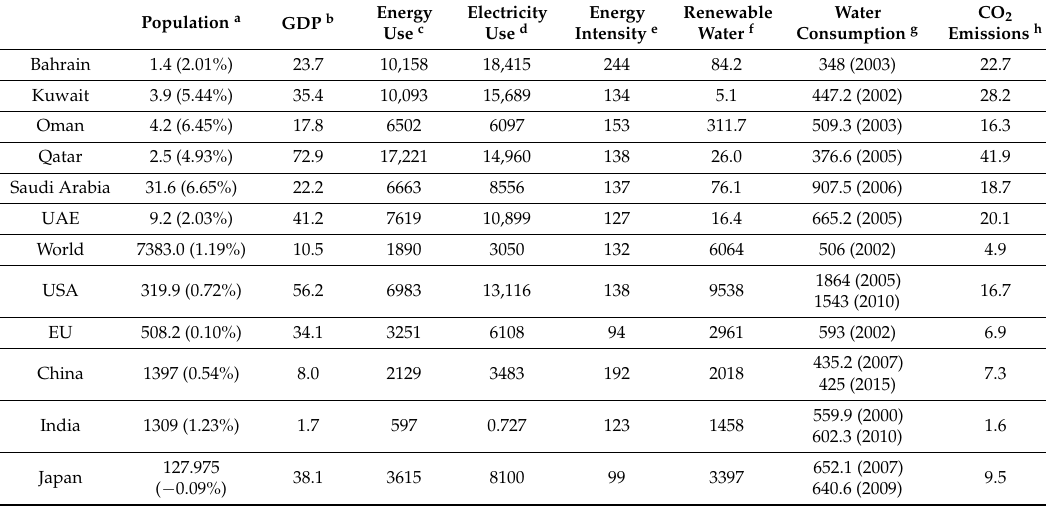
Table 5. General population, economic, energy, water, and emissions indicators for GCC countries, compared with the World average and other major energy users [4,125,126]. Population a GDP b